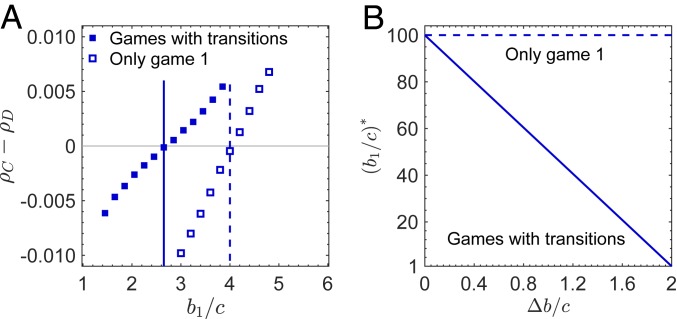
Game transitions can promote cooperation under death–birth updating. We study a transition structure between 2 donation games. A cooperator pays a cost c to bring its opponent a benefit b1 in game 1 or b2 in game 2; defectors pay nothing and provide no benefits. b1 is larger than b2. Mutual cooperation leads to game 1, and all other action profiles lead to game 2. Compared with only playing game 1, game transitions reduce the critical benefit-to-cost ratio, b1/c*, for the evolution of cooperation (cross-points of dots and the horizontal line in A). Dots show simulation data, and vertical lines represent analytical results. Parameter values are N=500, k=4, δ=0.01, c=1, and b2=b1−0.9. In each simulation, all players play game 1 initially. Each simulation runs until the population reaches fixation (all C or all D), and each point is averaged over 106 independent runs. A small difference between b1 and b2 (Δb=b1−b2) remarkably reduces the critical benefit-to-cost ratio b1/c* (B). We take k=100 in B.